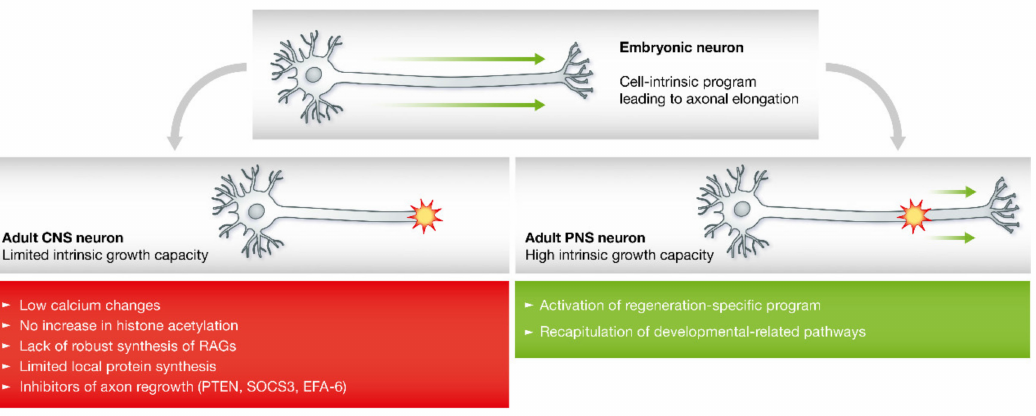
Figure 2. Increased growth capacity of PNS versus CNS neurons. CNS, central nervous system; EFA- 6, exchange factor for ADP-ribosylation factor 6; PNS, peripheral nervous system; PTEN, phosphatase and tensin homolog; RAG, regeneration-associated gene; SOCS3, suppressor of cytokine signaling 3. Adapted with permission from Ref. [32]. Copyright 2014, Wiley-Blackwell.